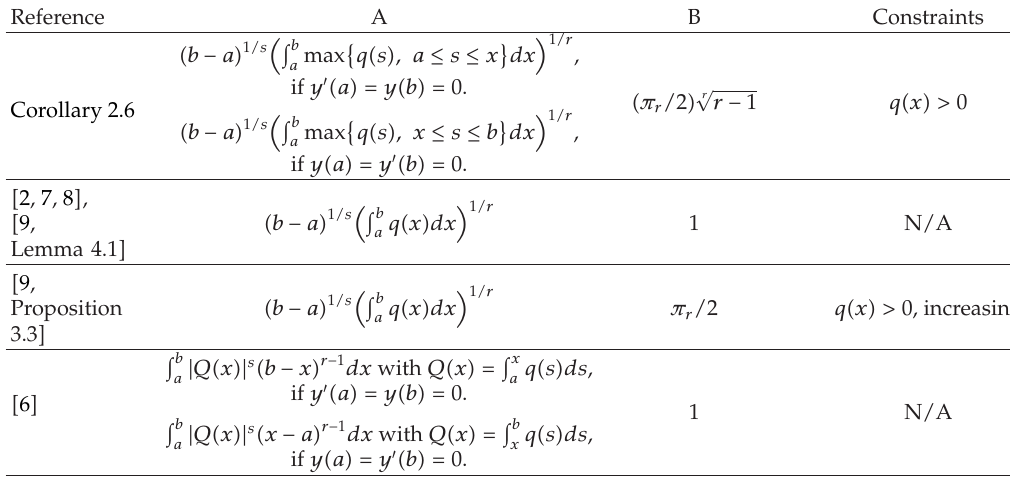
Table 5: Comparison of di ff erent lower